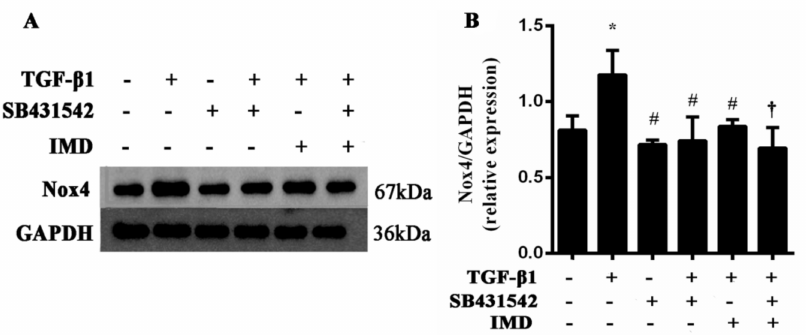
Figure 6. TGF- β 1-induced Nox4 expression is inhibited by IMD via TGF- β 1/ALK5-dependent pathway. ( A ) Representative Nox4 protein expression measured by Western blot in atrial fibroblast. ( B ) Densitometric quantifications of band intensities from Western blot for Nox4/GAPDH in atrial fibroblast. Data in bar graphs are means ± SD, n = 10. * p < 0.05 versus the control group, # p < 0.05 versus the TGF- β 1 group, † p < 0.05 versus the TGF- β 1 + IMD